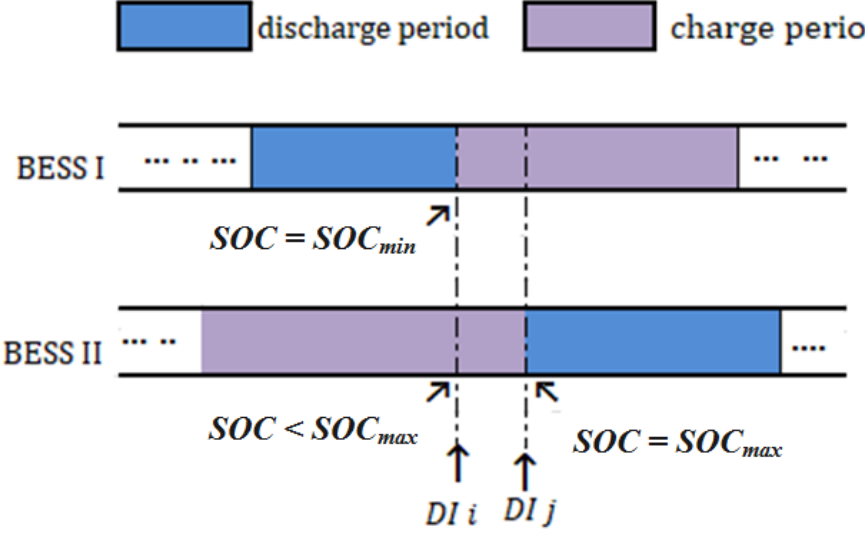
Figure 4. BESS’s asynchronous state exchange strategy [39].